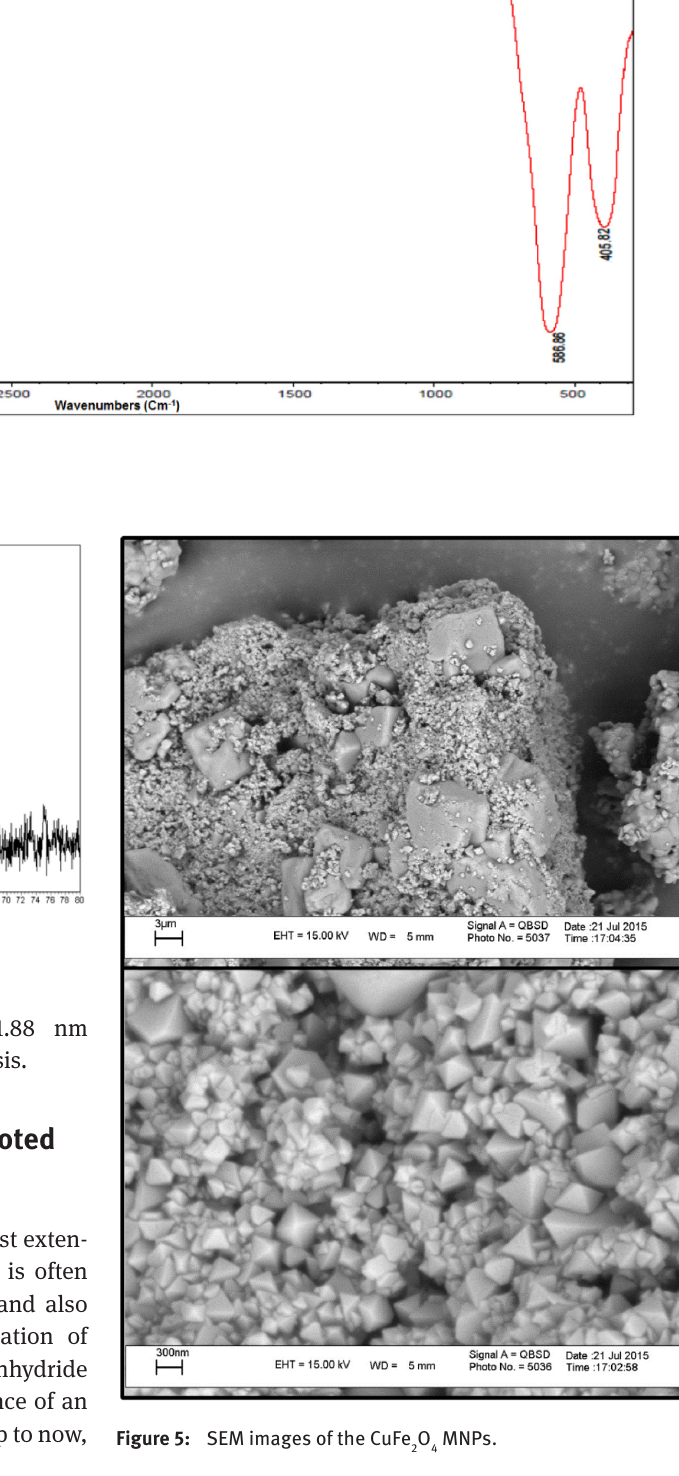
Figure 5: SEM images of the CuFe